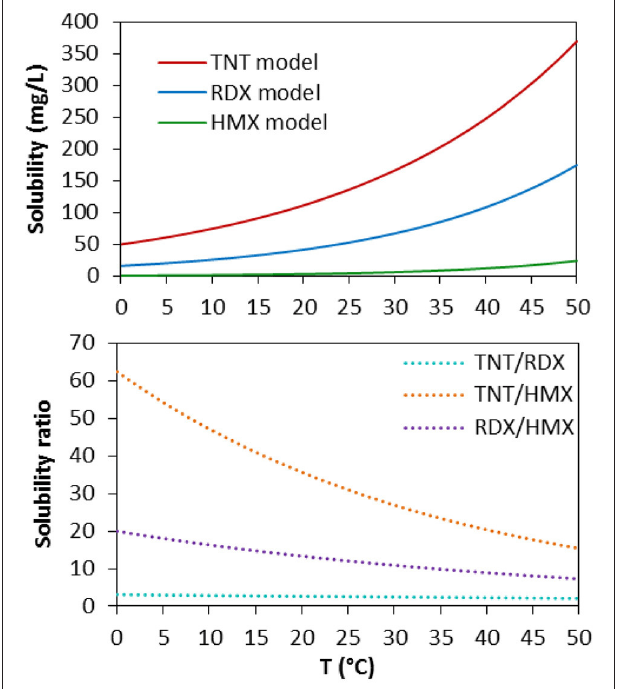
FIGURE 5 | (A) Solubility of TNT, RDX, and HMX as a function of temperature according to the exponential model ( Bier et al., 1999) ( Table 2 ). (B) Relative solubility of TNT, RDX, and HMX as a function of